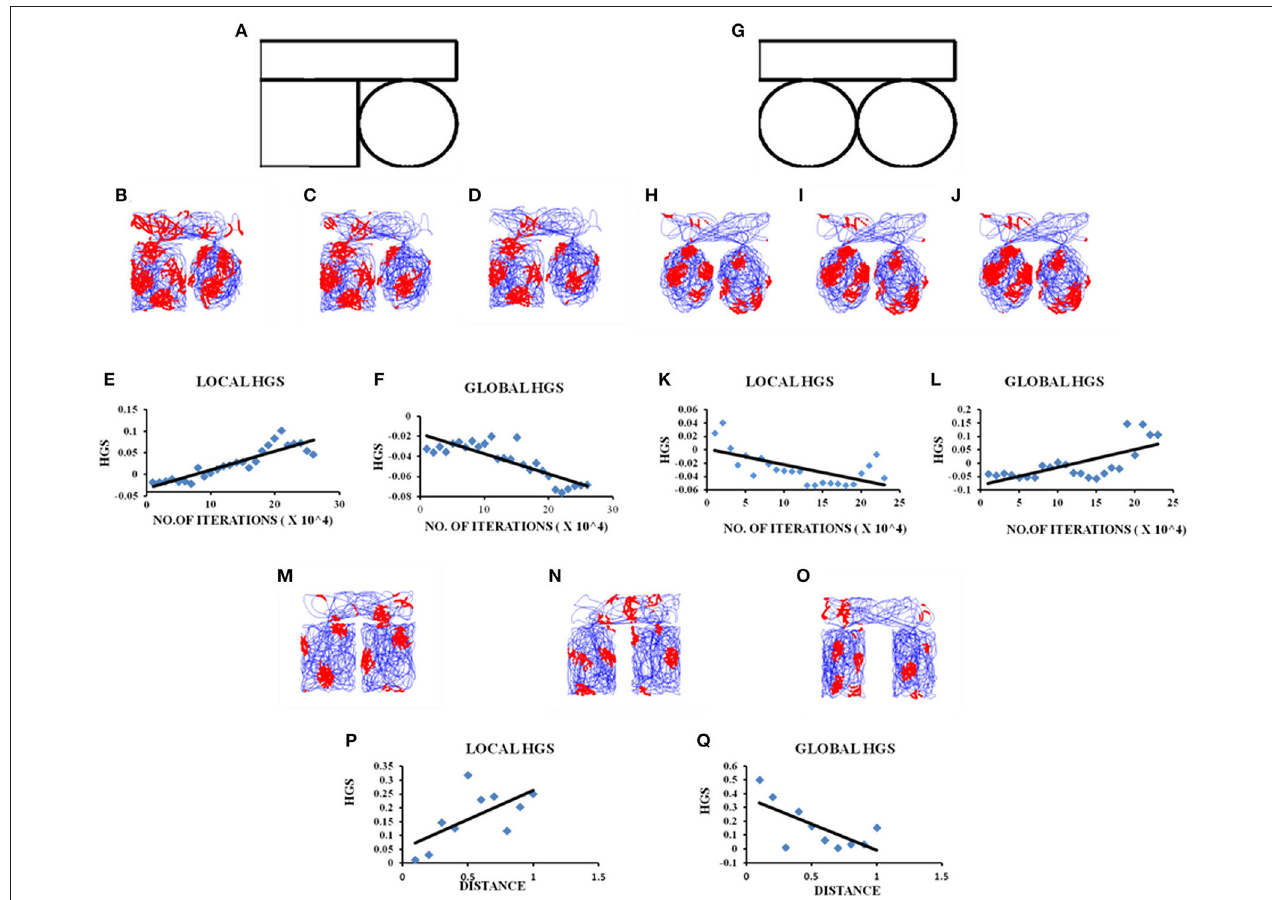
FIGURE 3 | Grid cell firing in circle-circle, square-circle environments and in square–square Connected Environment with increasing distances. (A) Boundary of square–circle connected environment. (B–D) represent the firing fields of the grid cell in the LAHN for square–circle connected environment at different training iterations (beginning, middle, and end, respectively) of the model. (E,F) Local and Global HGS values plotted against the no. of training iterations of model. (G) Boundary of circle–circle connected environment. (H–J) represent the firing fields of the grid cell in the LAHN for circle–circle connected environment at different training iterations (beginning, middle, and end, respectively) of the model. (K,L) Local and Global HGS values plotted against the no. of training iterations of model. (M–O) firing field maps (corresponding to end iteration of LAHN training) of the grid cell with respect to distances (d) = 0.1, 0.5, and 1 unit, respectively. (P,Q) Local and Global HGS final with respect to the distance between the